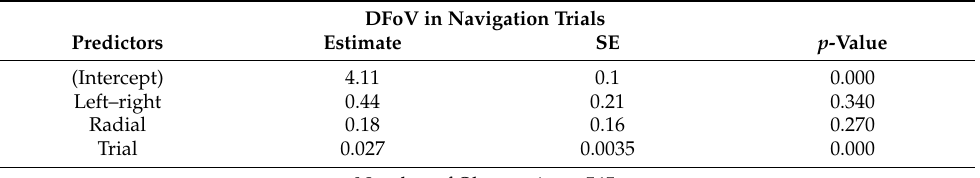
Table A1. Results of the analysis of DFoV in navigation trials. The applied model was a linear mixed-effects model that considered both random intercept and random slope.